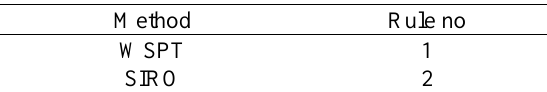
Table 3. Dispatching rules.